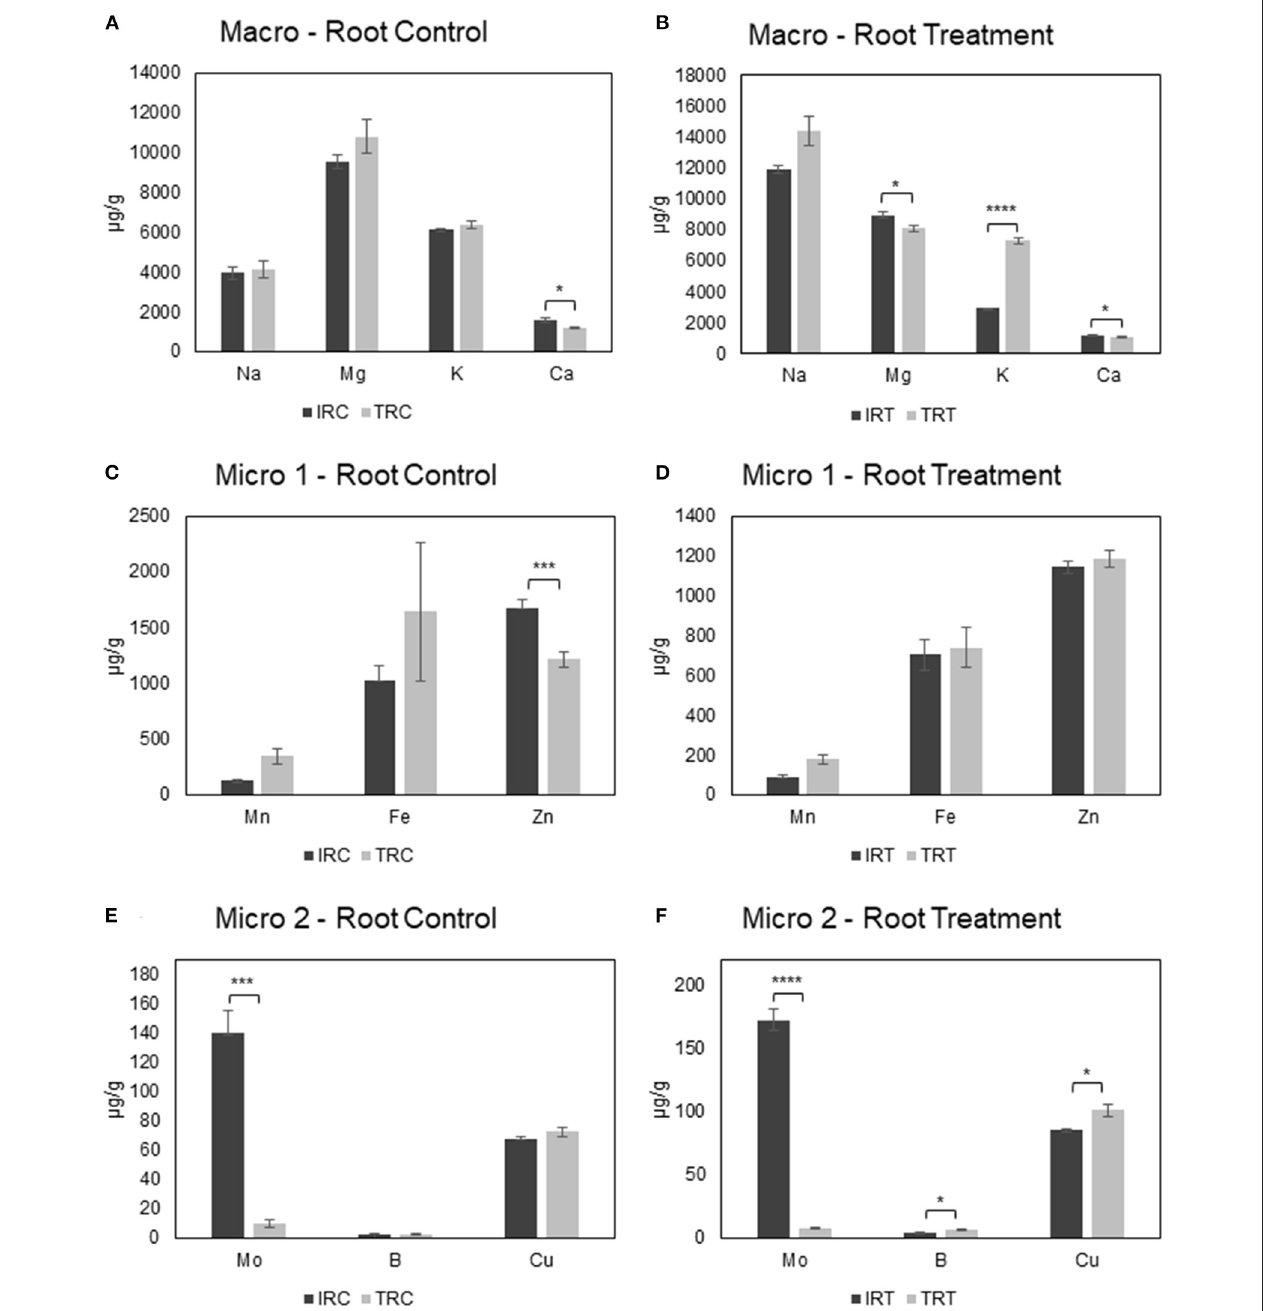
Supplementary Figure 4 | Comparison of root ion contents in control and saline conditions. (A,B) Display the macroelement content comparisons for control and treatment conditions respectively. (C–F) Display the microelement content comparisosn for control and treatment conditions respectively. * p < 0.05; ** p < 0.01; *** p < 0.005; **** p <